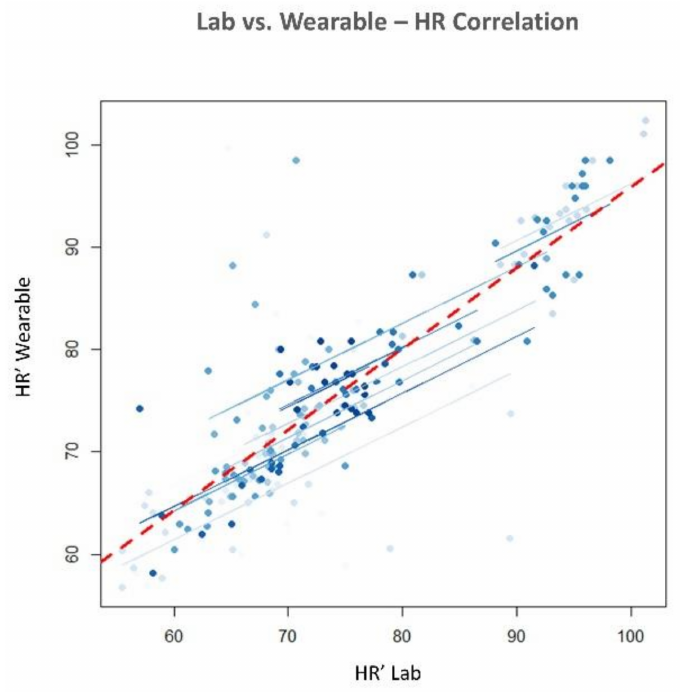
Figure 9. Pearson’s repeated measure correlation for the Heart Rate (HR) estimated with laboratory and wearable devices. R = 0.51, p <10 − 14 .